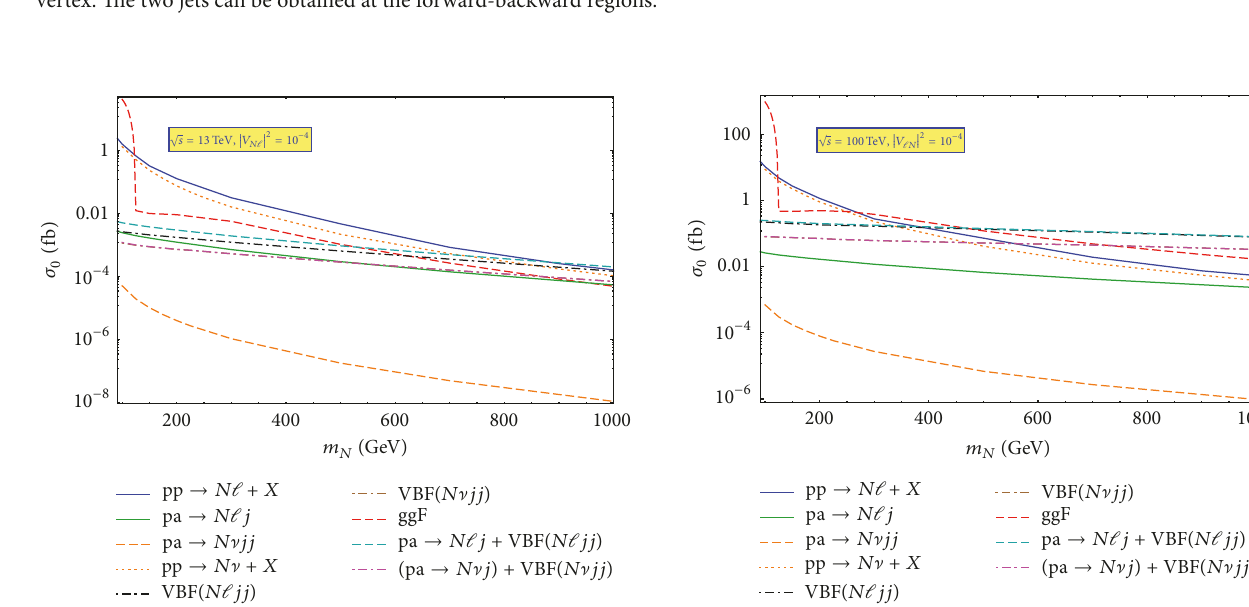
Figure 10: VBF production of the 𝑁ℓ𝑗𝑗 final state from the 𝑊 → 𝑁ℓ vertex. The 𝑁 ] 𝑗𝑗 finals state can also be obtained using the 𝑍 → 𝑁 ] vertex. The two jets can be obtained at the forward-backward regions.